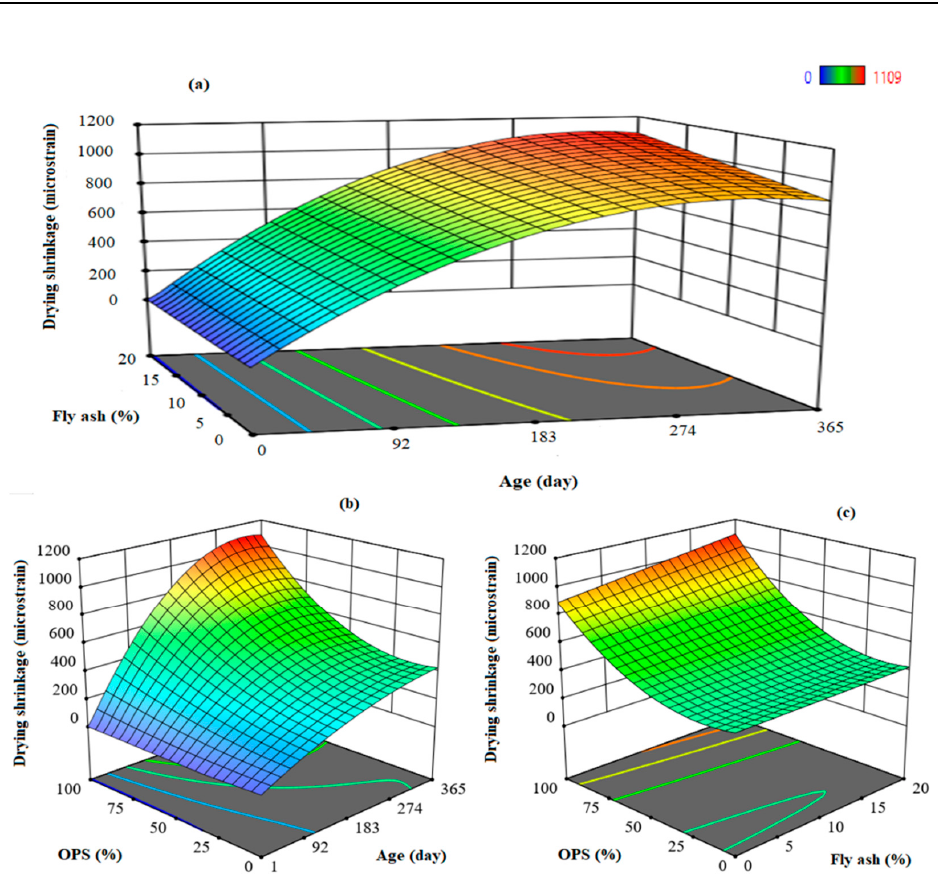
Figure 10. 3D response surface plots for drying shrinkage of LWC at ( a ): 100% OPS, ( b ): 20% FA, and ( c ): age of 365 days under 28-day water curing.